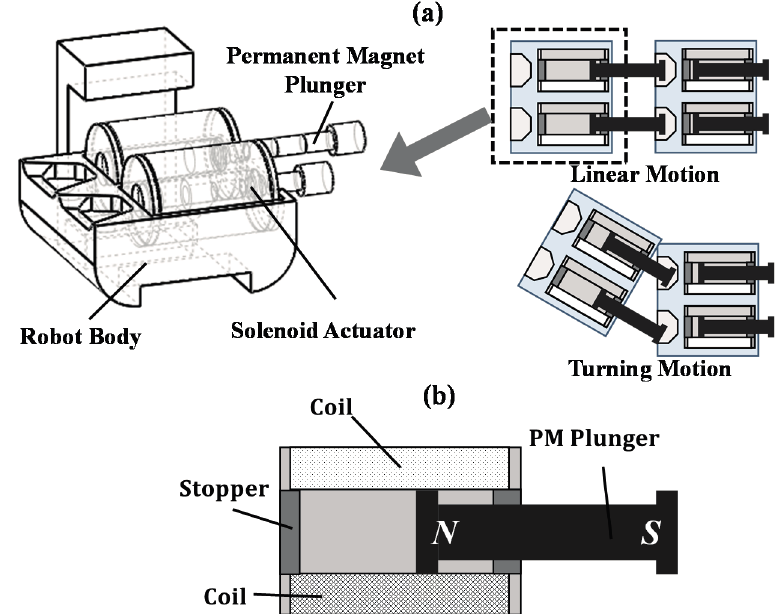
Figure 1. The design of a solenoid with a permanent magnet (PM) plunger: ( a ) the design concept of multi-segment robots with linear and turning motions using a pair of solenoids; ( b ) the cross-sectional view of the proposed solenoid actuator with PM